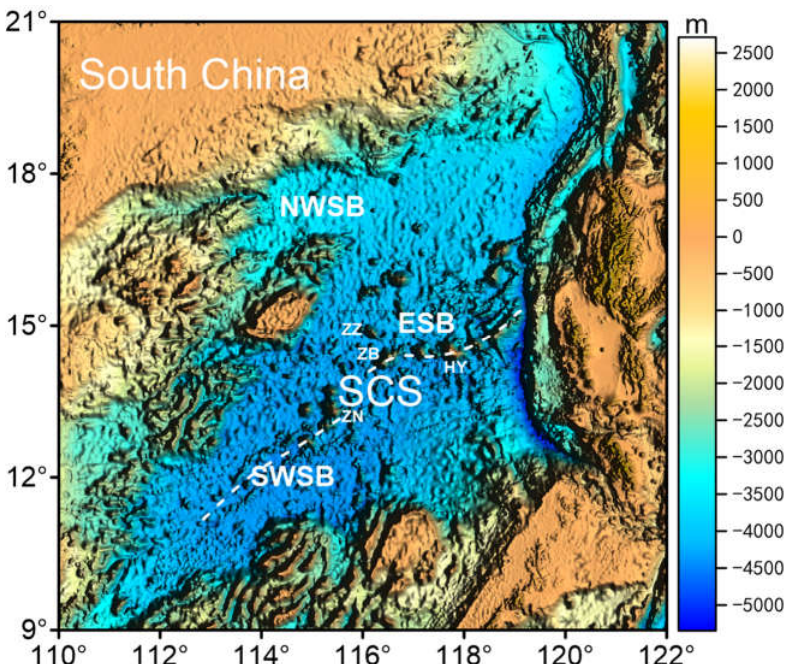
Figure 1. The topography of the South China Sea. ESB, eastern sub-basin of the SCS; NWSB, northwestern sub-basin of the SCS; SWSB, southwestern sub-basin of the SCS; ZZ, Zhangzhong seamount; ZB, Zhenbei seamount; ZN, Zhongnan seamount; HY, Huangyan seamount. The dashed white line denotes the fossil spreading ridge. The topographic data are derived from the General Bathymetric Chart of the Oceans (GEBCO).